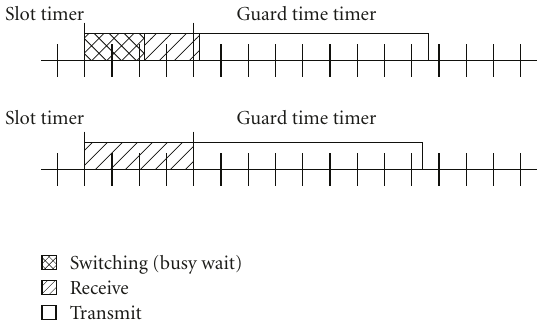
Figure 10: Radio states at the start of an LMAC slot for hardware implementation (top) and simulation